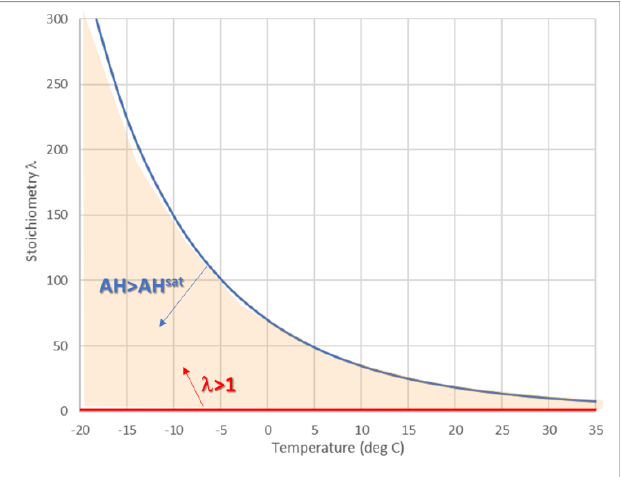
Figure 3. Sufficient stoichiometry airflow for both FC operation (red line) and obtaining a fully saturated air (blue line) as a function of minimal air temperature in the WRS.